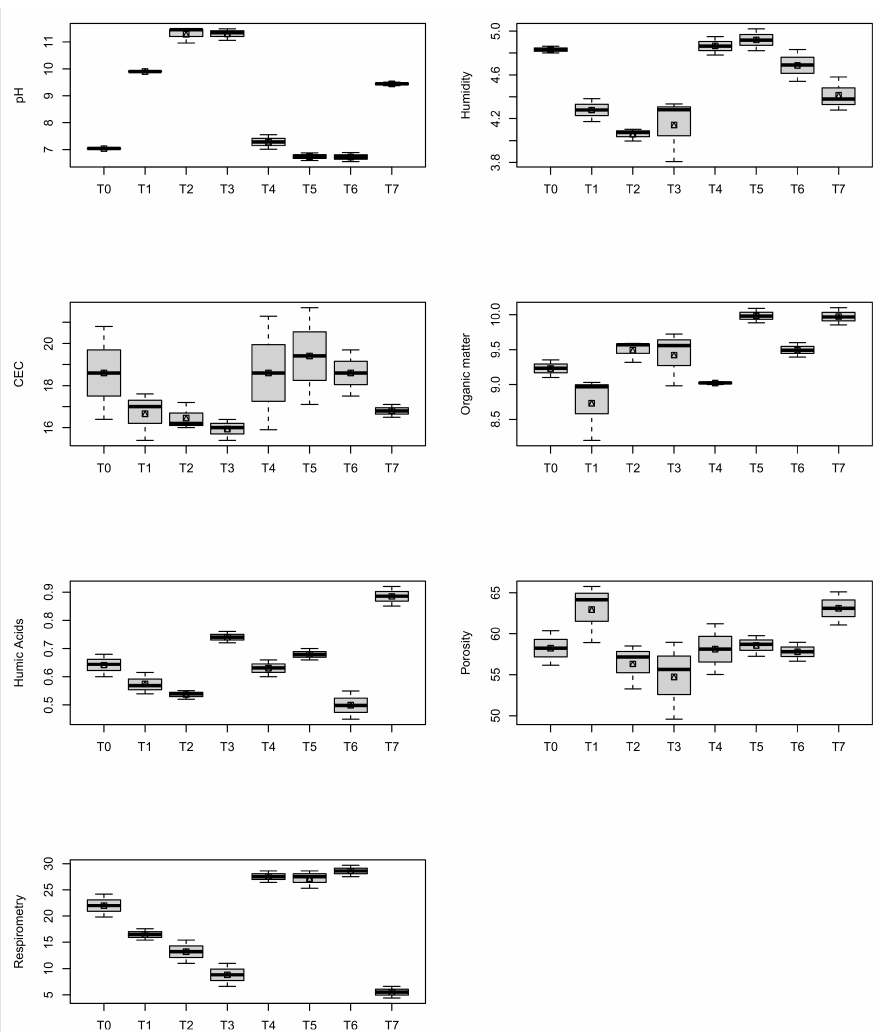
Figure 2. Boxplot of the physical and chemical characteristics after three months of applying the treatments. The mean is shown in red. Units: humidity in %, CEC in Meq/100, organic matter in %, humic acids in in %, respirometry in mg of CO 2 . T0: soil without treatment; T1, T2, and T3: soils treated with lime at 1, 2, and 3%, respectively; T4, T5, and T6: soils treated with 40 nm silica nanoparticles at 0.5, 1, and 2%, respectively; T7: soil treated with 0.5% nanosilica and 2%